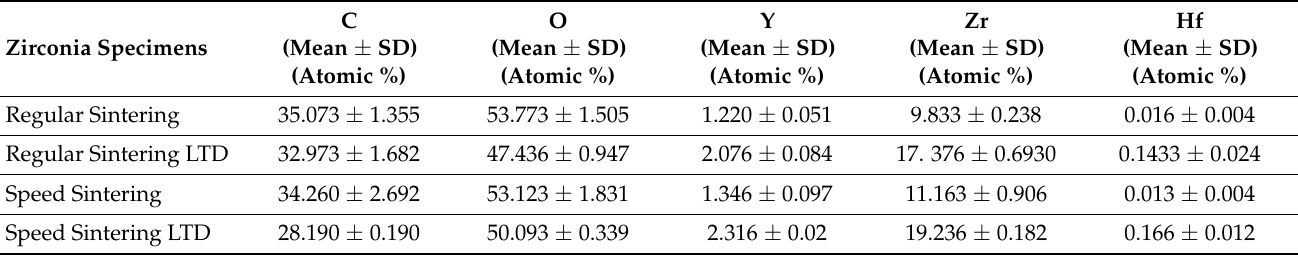
Table 3. Results of the EDS elemental analysis of the zirconia specimens for the regular speed sintering and speed sintering with and without low-temperature degradation (LTD).